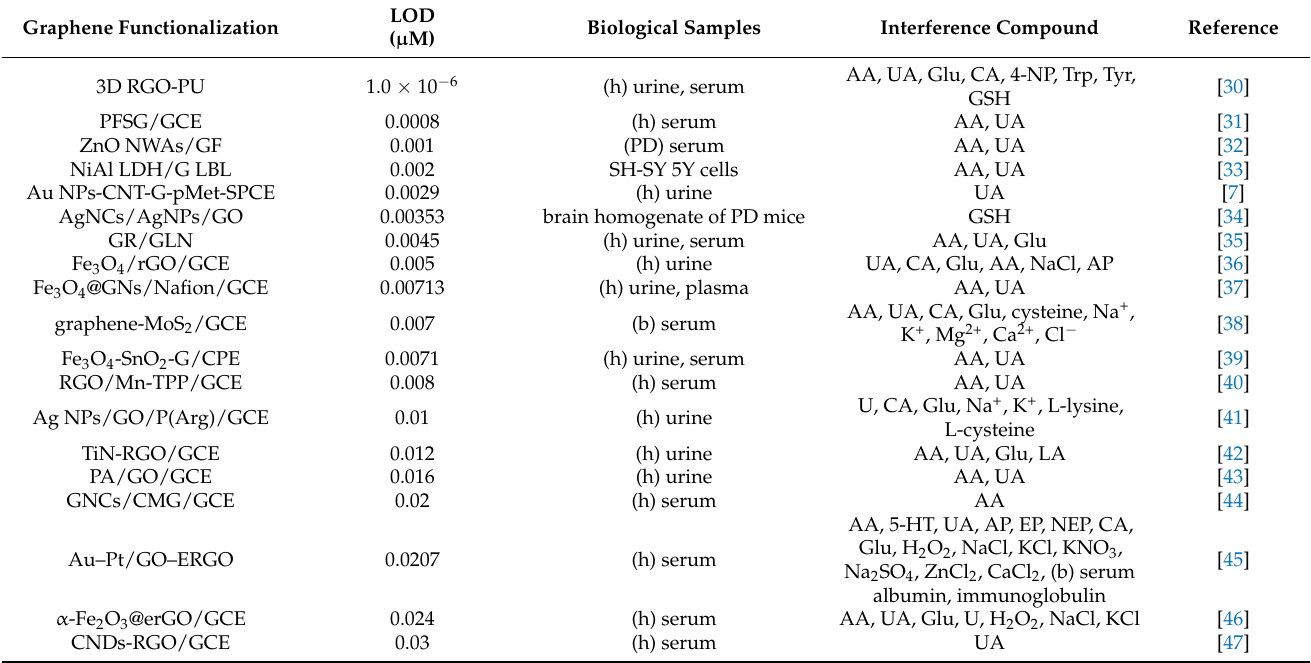
Figure 3. ( a ) Schematic diagram of an OECT device for DA sensing. ( b ) Optical image of the transistor and the whole OECT array. ( c ) Channel transconductance (gm) response to additions of DA with different concentrations [28]. ( d ) Fabrication of flexible electrochemical DA sensor with a Pt-AuNPs/LIG/PDMS electrode and display of flexibility of the fabricated electrode [29]. Table 1 summarizes the analytical performances of DA biosensors as claimed by various reports [9,30–61]. Table 1. Analytical performances of DA biosensors.